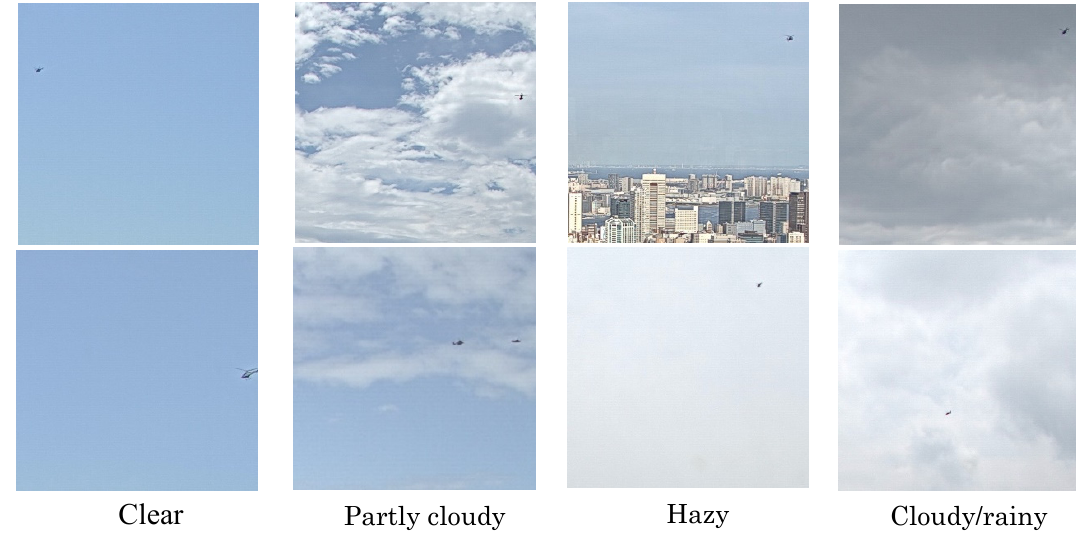
Figure 5. Categorization of data by type of weather.